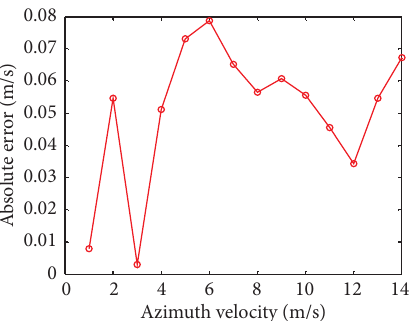
Figure 4: Absolute error in the azimuth velocity estimation from the contrast method.